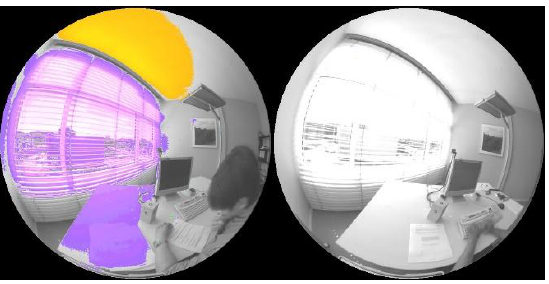
Figure 43. Extreme example (laboratory study) of the difference in glare source(s) detection resulting from the b1000_r0.06 setting ( left ) and the b7_Lb setting ( right ) in evalglare.